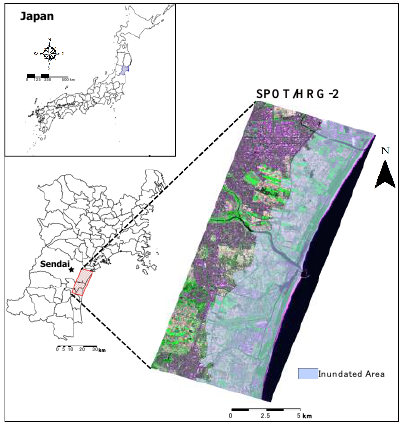
Figure 1. Map of Tohoku Region showing Sendai Bay study area. SPOT/HRG-2 image shows stretch of coastal plain inundated by the tsunami. © CNES 2010-2011, Distribution Astrium Service/Spot Image